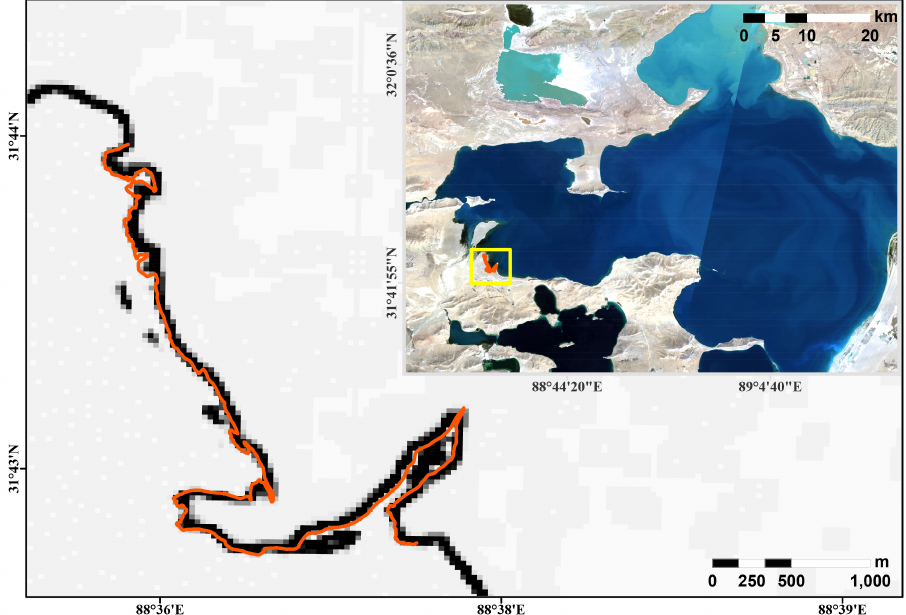
Figure 7. In-situ GPS trajectory (orange line) and the predictive edge pixels (black line) in the comparison region (yellow